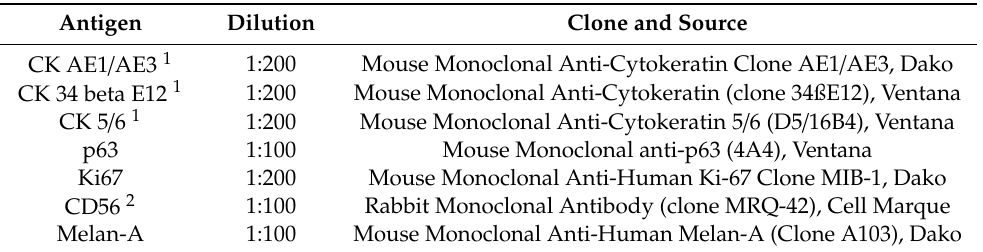
Figure 2. Haired skin: cut section of the cutaneous mass located in the left pinna. Two distinct multilobulated masses circumscribed by multiple white-yellowish bands and measuring 3 × 1.2 × 1 cm (arrow) and 1.3 × 1.2 × 0.5 cm (asterisk) are observed. Bar: 0.5 cm. Table 1. Panel of primary antibodies and their dilutions used for